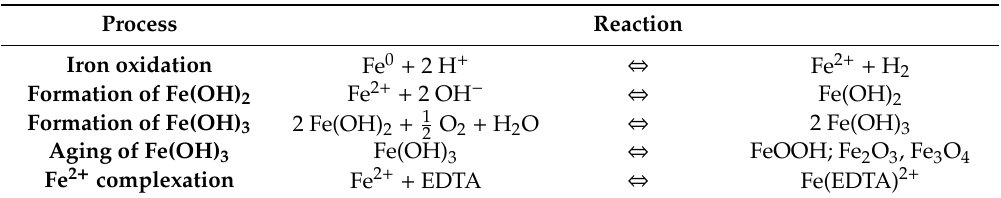
Table 1. Some relevant reactions for the discussion of the e ffi ciency of metallic iron (Fe 0 ) in remediation Fe 0 / H 2 O systems.